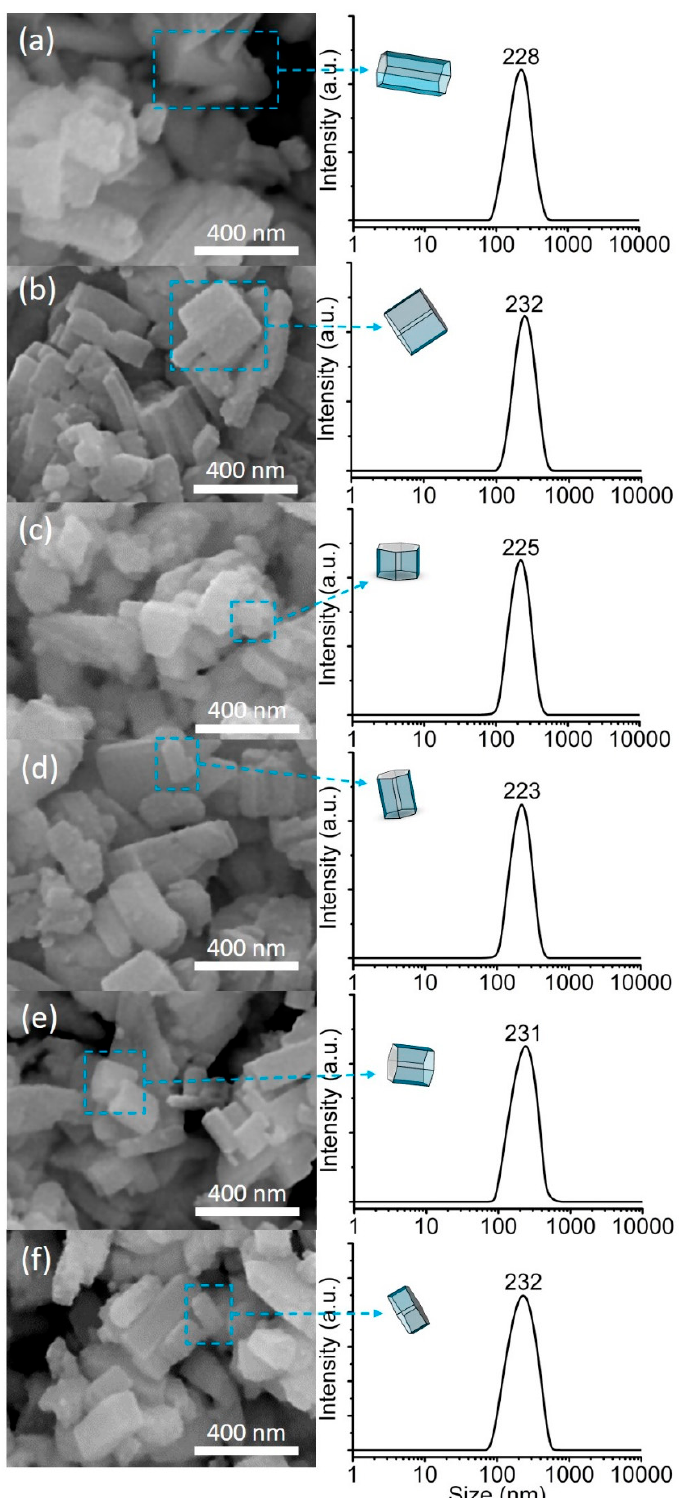
Figure 3. SEM images and crystal size distributions based on the length of the hexagonal prisms of ( a ) pristine SAPO-5, ( b ) CuCl x /SAPO-5, ( c ) CoCl x /SAPO-5, ( d ) SnCl x /SAPO-5, ( e ) FeCl x /SAPO-5 and ( f ) ZnCl x /SAPO-5. The selected hexagonal prism crystals in each sample are also highlighted and compared with the theoretical ones.